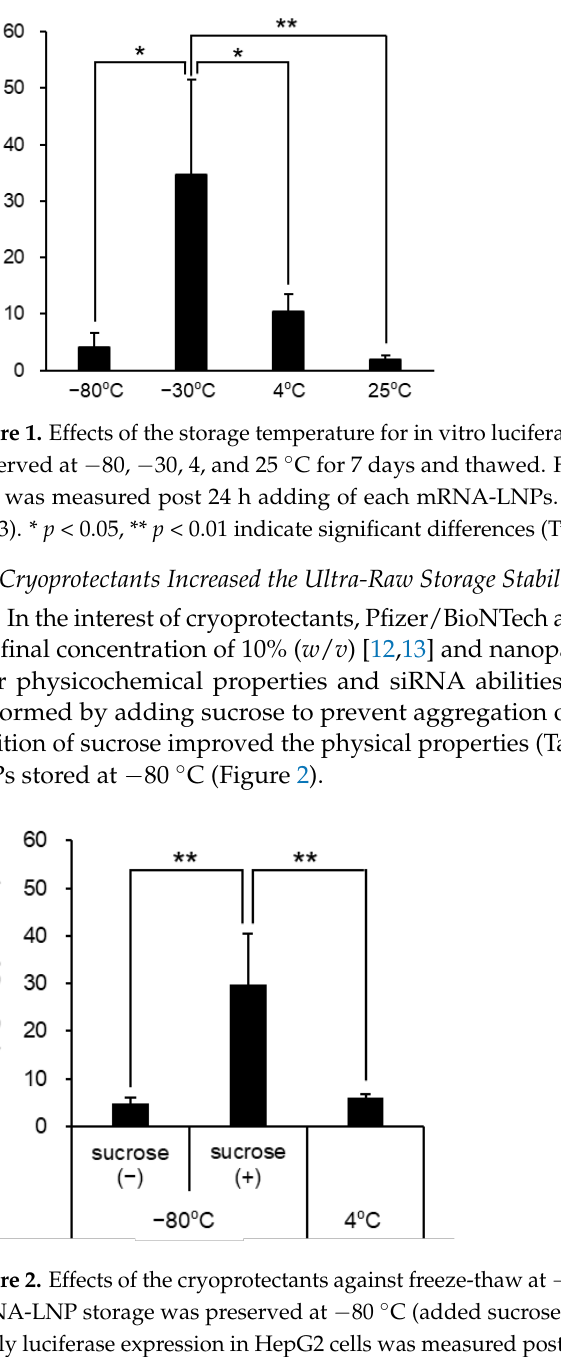
Figure 2. Effects of the cryoprotectants against freeze- thaw at −80 °C for in vitro luciferase assay. The mRNA- LNP storage was preserved at −80 °C (added sucrose or not) or 4 °C for 7 days and thawed. Firefly luciferase expression in HepG2 cells was measured post-24 h, adding each mRNA-LNPs. Data are represented as mean + S.D. ( n = 3). ** p < 0.01 indicate significant differences (Tukey’s test).